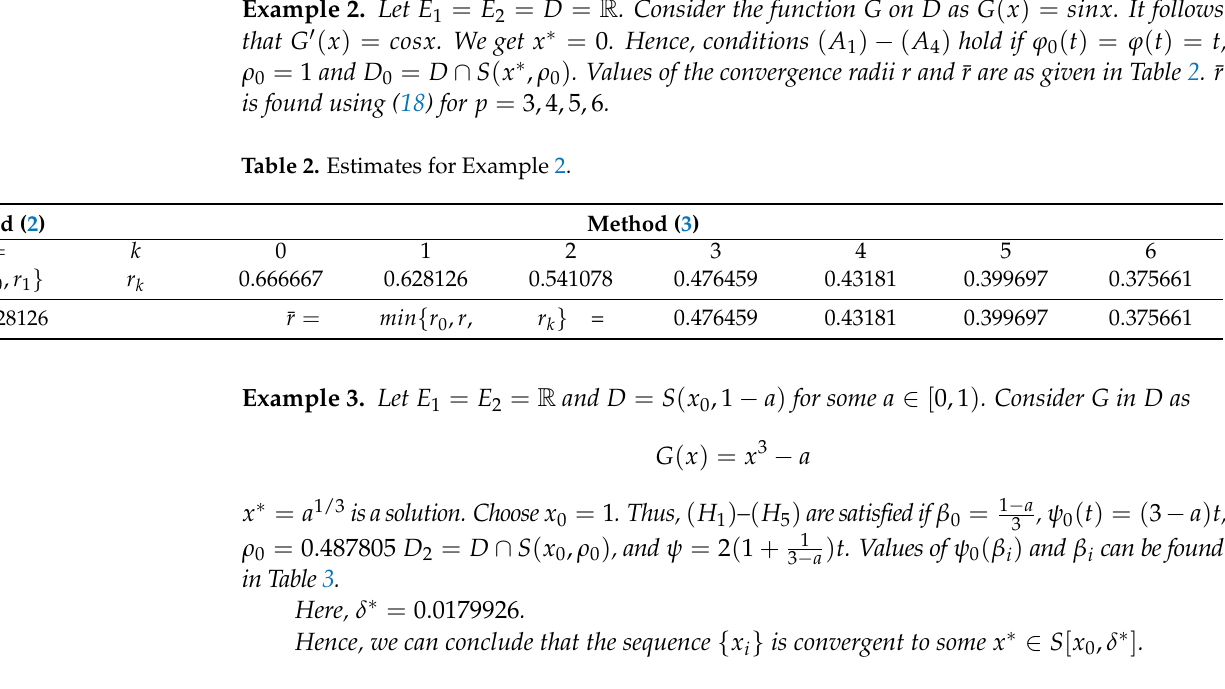
Table 3. Estimates for Example